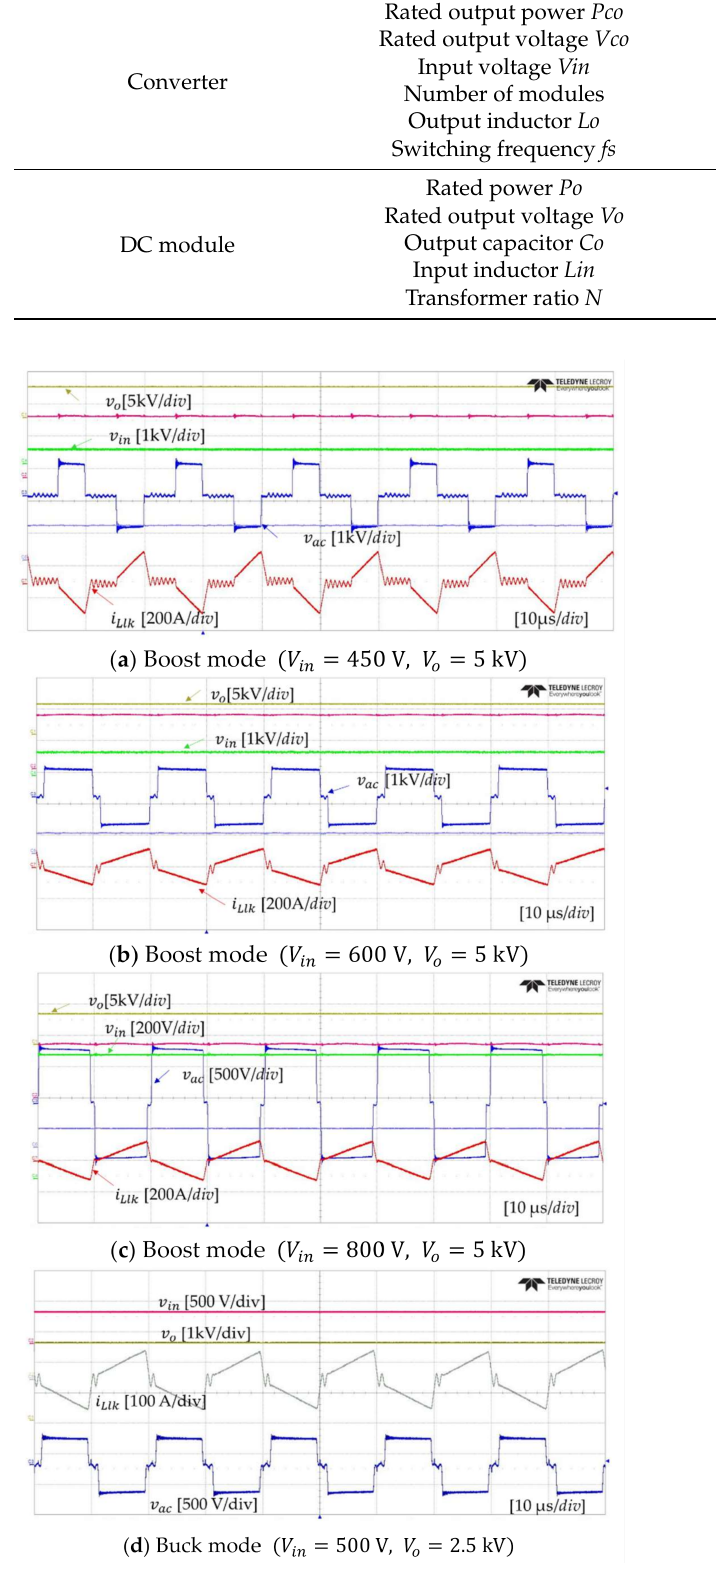
Figure 20. Experimental waveforms of dc module in two